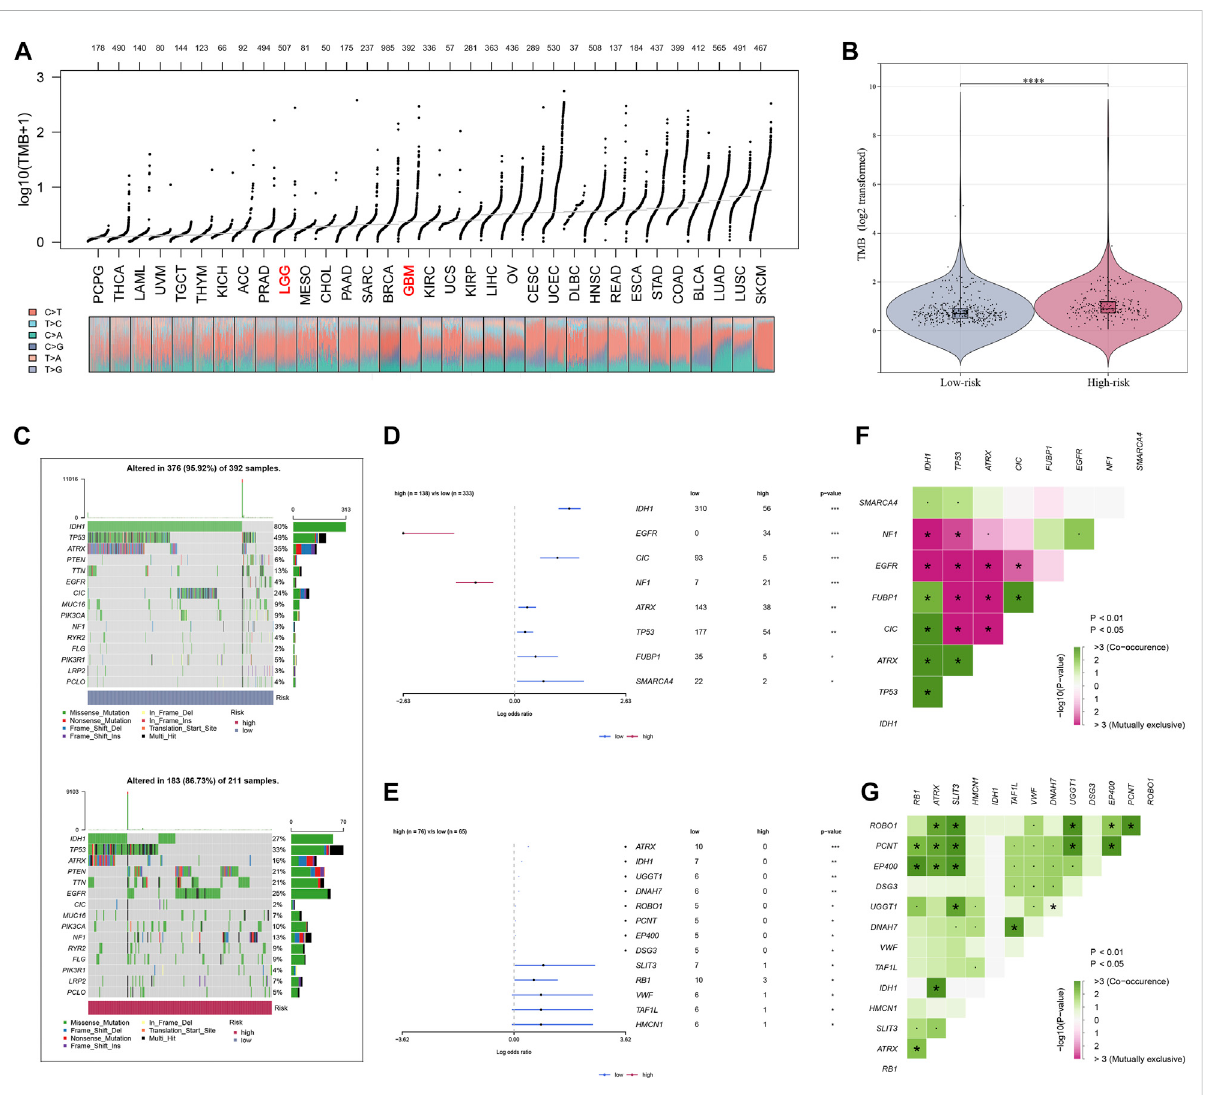
FIGURE 6 Analysis of tumor mutation characteristics. (A) TMB value display of all cancer types in TCGA. (B) TMB difference analysis between high- and low-risk groups of glioma patients. (C) The pro fi les of mutations between high- and low-risk groups of glioma patients. (D,E) Analysis of mutated gene differences between high- and low-risk groups in patients with glioma. (F,G) Co-mutation correlation of mutated